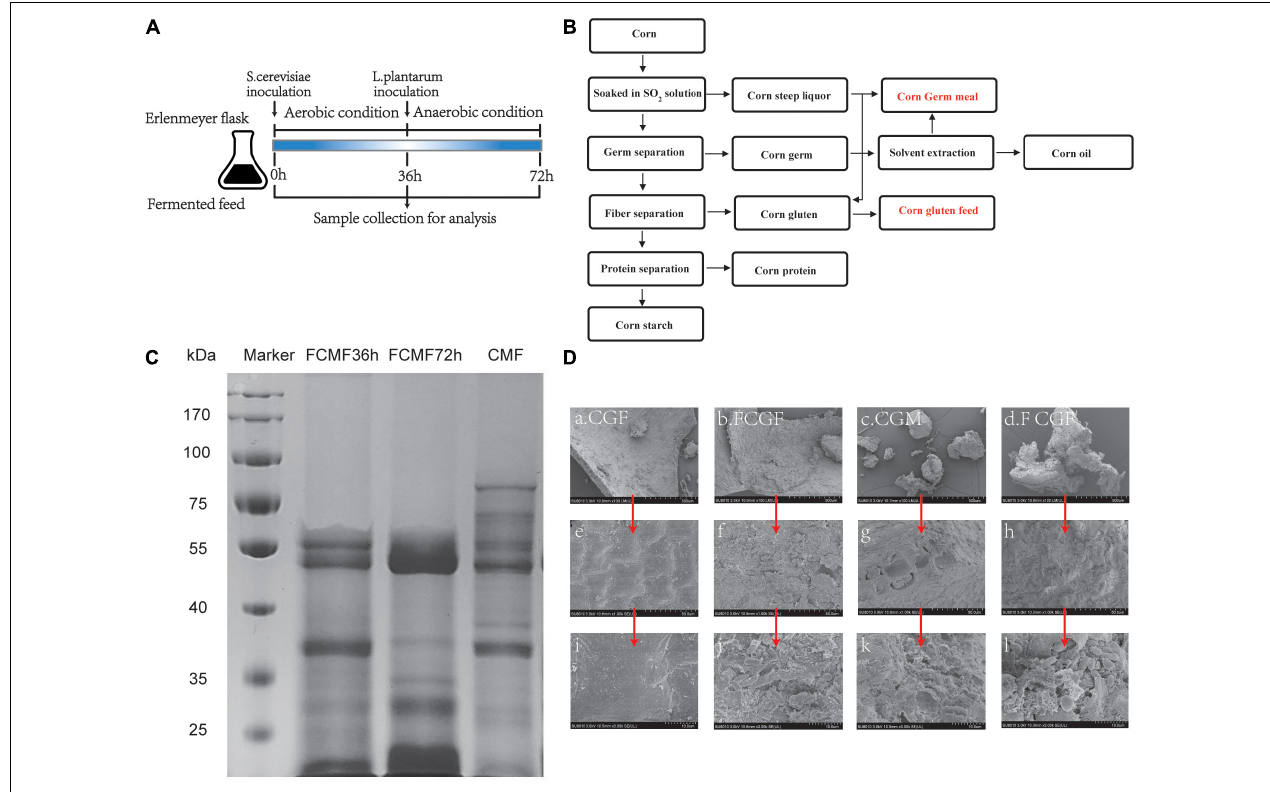
FIGURE 2 | Experimental design, electrophoresis, and scanning electron microscopy (SEM) image of corn byproduct mixture feed (CMF) and fermented CMF (FCMF). (A) Experimental design. (B) Simplified process of corn wet milling for starch production and its byproducts. (C) Sodium dodecyl sulfate-polyacrylamide gel electrophoresis (SDS-PAGE) of FCMF at fermentation times of 0, 36, and 72 h. (D) SEM images of CMF and FCMF after 72 h of fermentation at × 100 (a–d) , × 1,000 (e–h) , and × 3,000 (i–l) fold